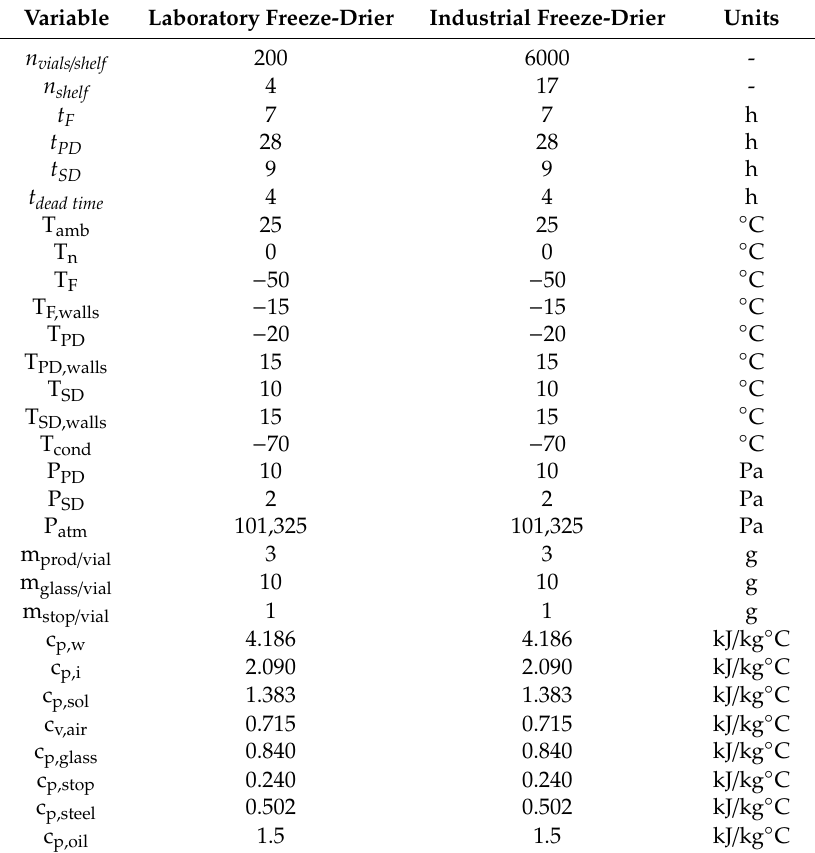
Table A1. List of the variables used in this work and their numerical